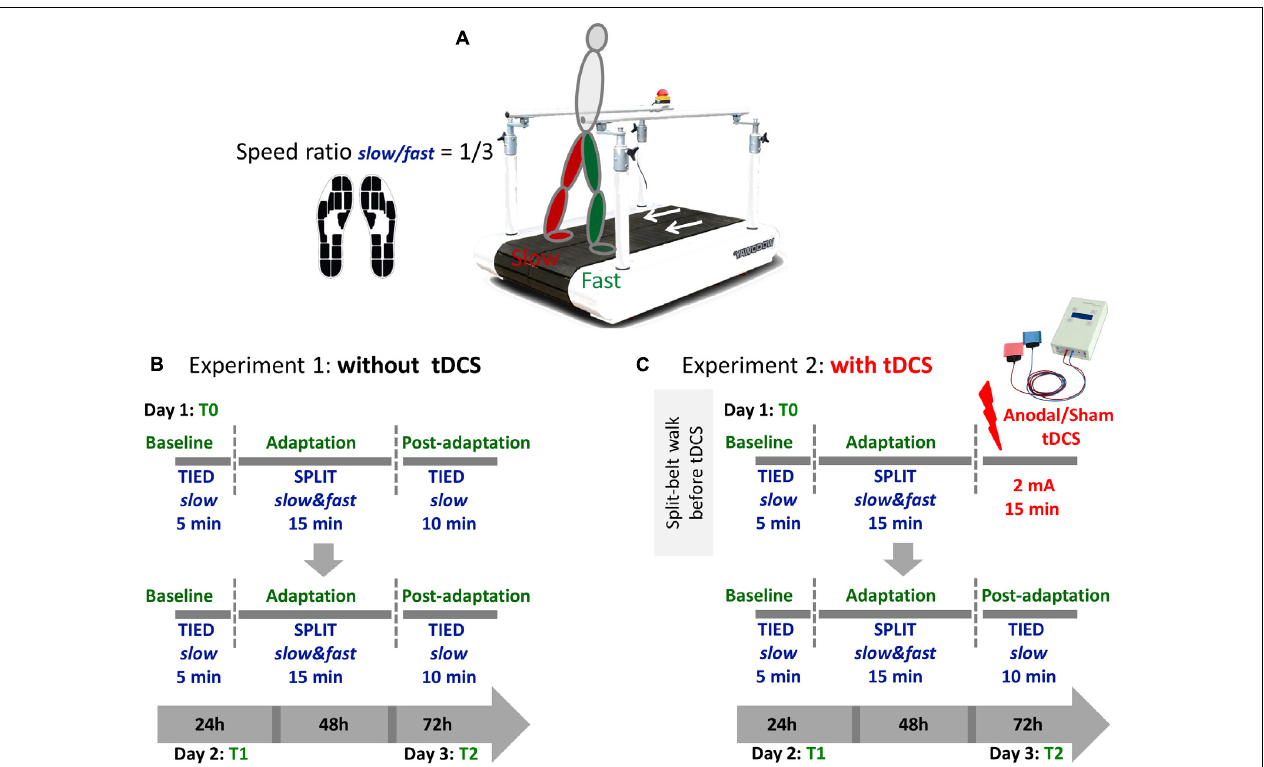
FIGURE 1 | (A) Participants walked on a split-belt treadmill with a speed ratio 1/3 between the slow and the fast leg during the adaptation phase. Namely, the faster belt moved at the maximal speed obtained during the 25FWT and the slower belt always moved at the 1/3 of that speed. Gait parameters where recorded using sensor insoles. (B) Each session consisted of three phases (baseline, adaptation, and postadaptation). The clinically less affected leg (people with MS) or the dominant leg (controls) walked on the fast belt. During the baseline period, subjects walked with both belts tied at a slow speed for 5 min. During the adaptation period, they walked for 15 min in a split-belt condition, with one leg moving fast and the other slow. During the postadaptation period, subjects walked for 10 min with both belts tied at the slow speed. This training was repeated 24 h (T1) and 72 h (T2) after the first session. (C) In experiment 2, participants received anodal or sham tDCS over the cerebellum ipsilateral to the less affected/dominant leg immediately after the adaptation phase at T0 only. On the following days, the experiment was performed without